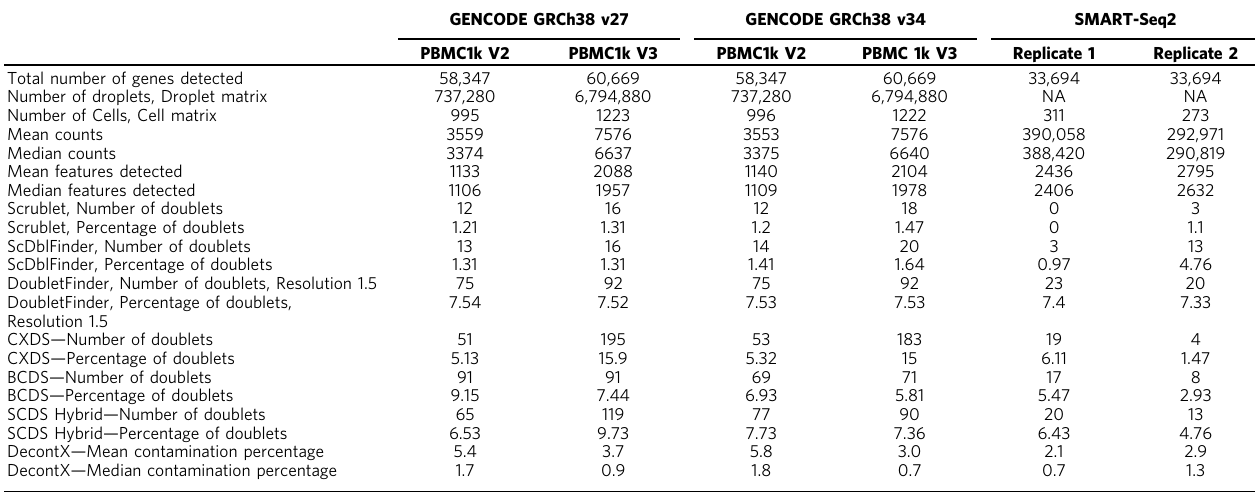
Table 3 Summary of QC metrics for each PBMC sample. A total of six PBMC datasets were analyzed with the SCTK-QC pipeline.